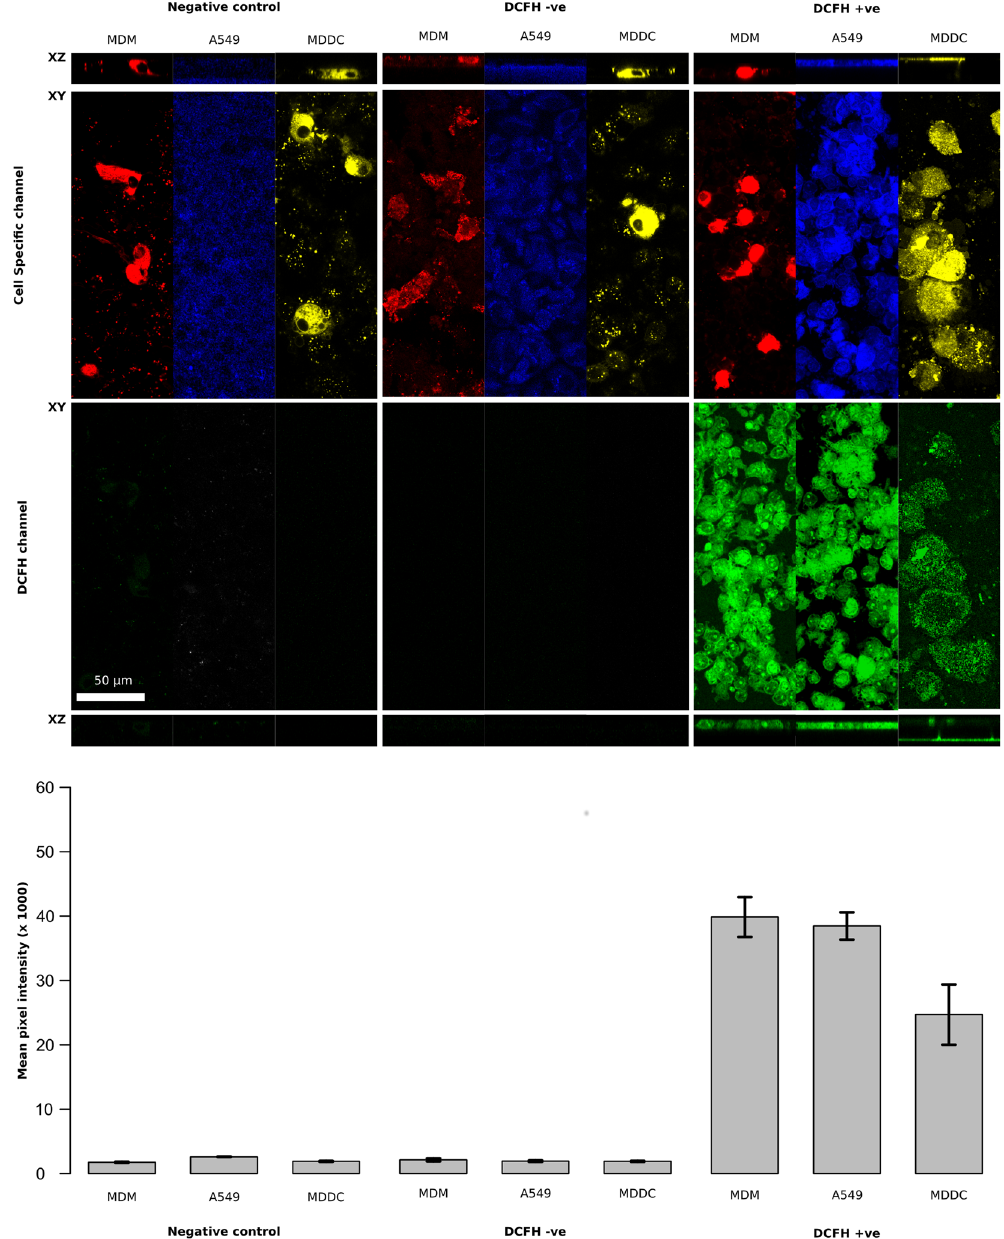
Figure 7. Ability to detect the production of reactive oxygen species (ROS) using the fluorescent probe 2 ′ ,7 ′ -dichlorfluorecein-diacetate (DCFH 2 -DA) ( i.e. the DCFH-DA assay) in the 3D in vitro triple cell co-culture of the human lung epithelial tissue barrier via live confocal laser scanning microscopy (LSM). To denote each specific cell type, live cell dyes (Vybrant Multicolor, Cell-Labeling Kit (Molecular Probes, Switzerland) were used to identify both the human blood monocyte derived macrophages (MDM; DiL (549/565 nm)) and dendritic cells (MDDC; DiD (644/665 nm)). A Cell Tracker Violet live dye (Molecular Probes, Switzerland) was then used to define the A549 epithelial cell layer apart from the specifically stained immune cell caches. ROS production was subsequently determined in the co-culture system following 4 hours exposure to either complete medium or tert -Butyl hydrogen peroxide ( t BHP) at [0.04 mg/mL]. Following the exposure period, the co-culture was stained with 1:10 dilution of 1 mM DCFH-DA (488 nm). A DCFH-DA treated control (DCFH-ve) was also performed to denote any non-specific fluorescence within the sample. Representative images of each specific cell type under the same exposure conditions are shown the XY and XZ planar views in 2D. Semi-quantitative analysis shown in the lower bar-charts was determined using the cell specific marker and calculated on a single cell